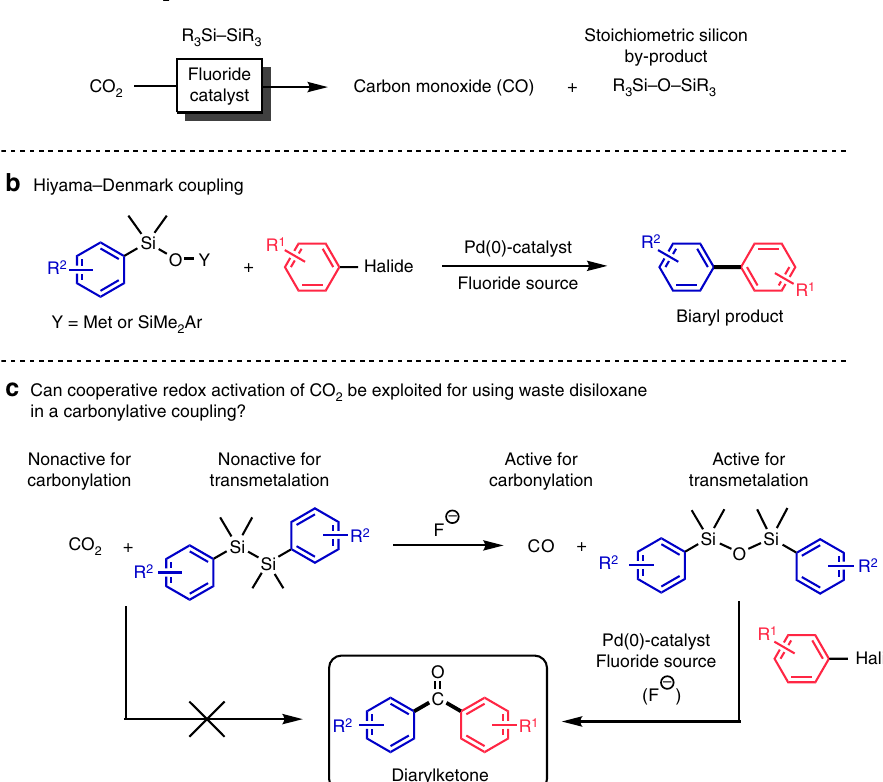
Figure 1 | General concepts in cooperative redox activation with carbon dioxide. Figure shows the overall strategy. ( a ) Reduction of CO 2 to carbon monoxide with disilanes produces stoichiometric silicon wastes. ( b ) Arylsilanolates and diaryldisiloxanes are viable reagents for their palladium-catalysed cross coupling with aryl halides to produce biaryls. ( c ) CO 2 and diarylsilanes cannot directly afford diarylketones in the presence of an aryl halide and a palladium catalyst. But through cooperative redox activation, these two reagents are transformed to carbon monoxide and a diarydisiloxane, which can participate in the three-component carbonylative